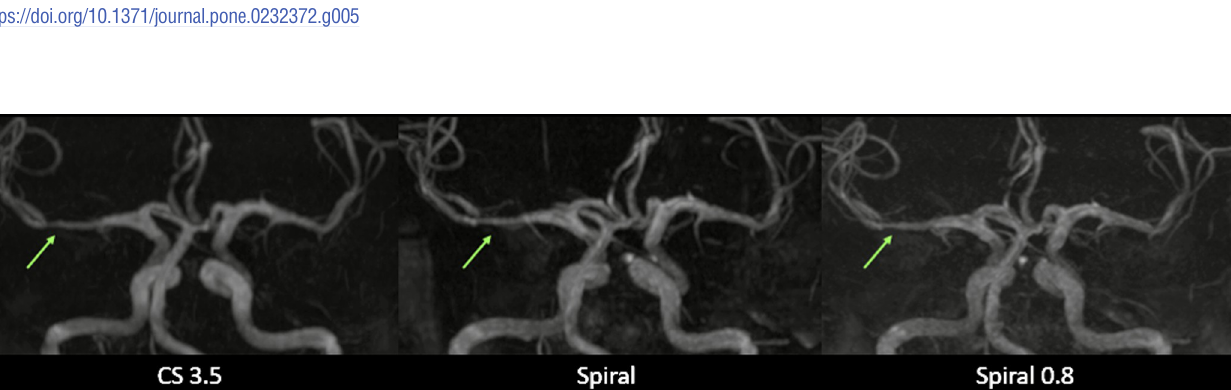
PLOS ONE | https://doi.org/10.1371/journal.pone.0232372 April 29,